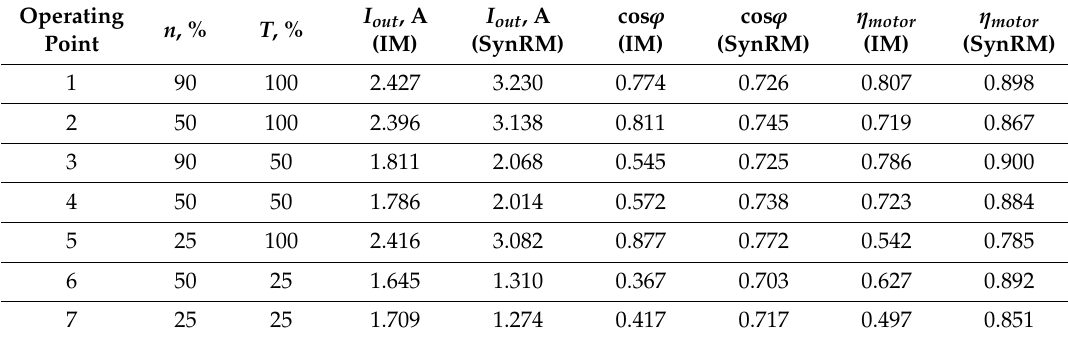
Table 4. Experimental measurements of the performance of the IM and the SynRM at several operating